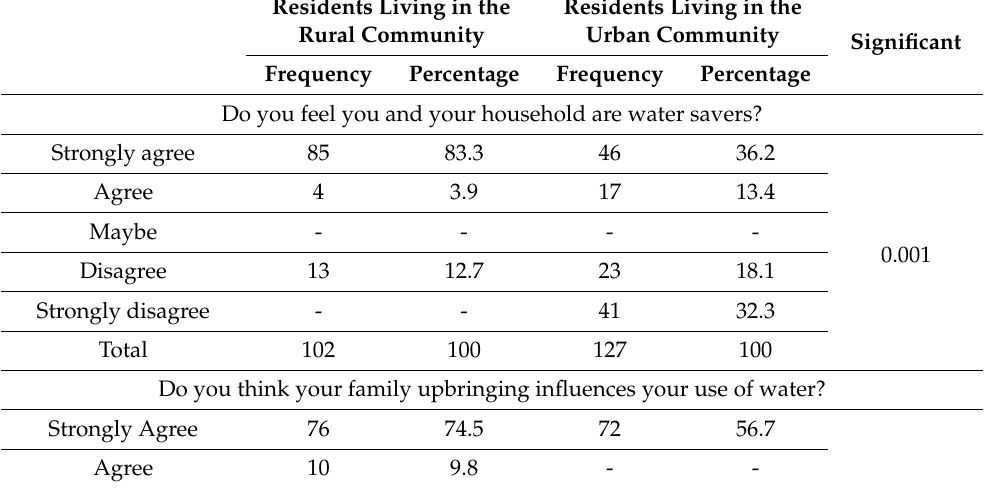
Table 3. Perception of the participants towards domestic water usage. Residents Living in the Residents Living in the Rural Community Urban Community Significant Frequency